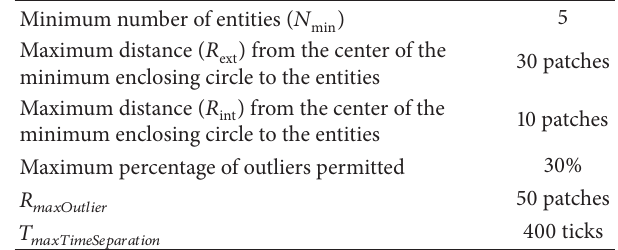
Table 4: Parameters to generate formations in NetLogo using Wilensky’s model.